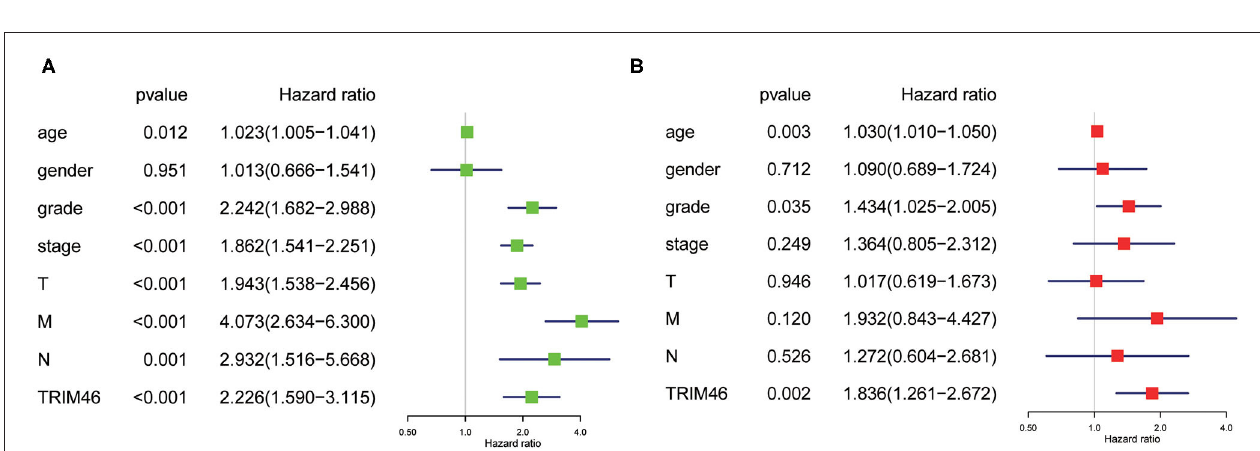
FIGURE 2 | The relationship between TRIM46 and clinical features. (A) Stage; (B) grade; (C) T stage; (D) N stage; (E) M stage. (F) Kaplan-Meier survival analysis.